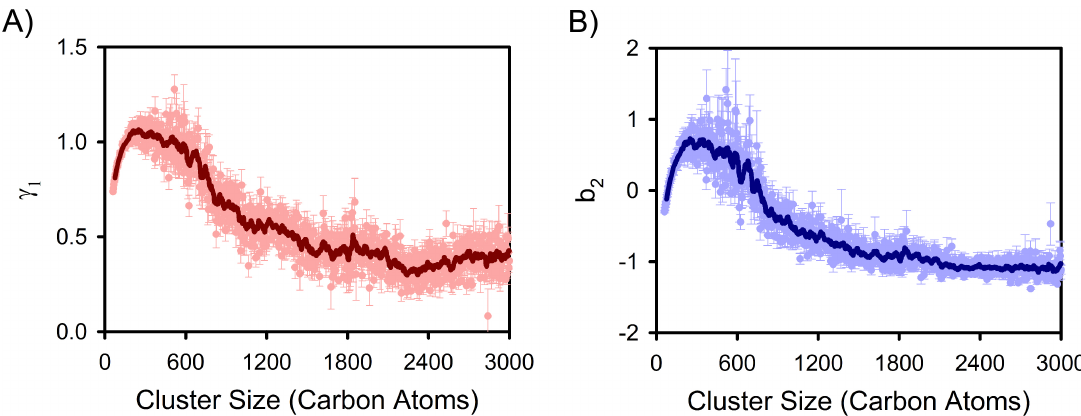
Figure 5. The skewness ( A ) and excess kurtosis ( B ) of stem distributions during polymer crystal nucleation and subsequent growth. In each panel, the dark curve corresponds to a rolling average with a period of 30 carbon atoms to guide the eye. The pale data points correspond to the underlying values for individual nucleus sizes, and the error bars are standard error